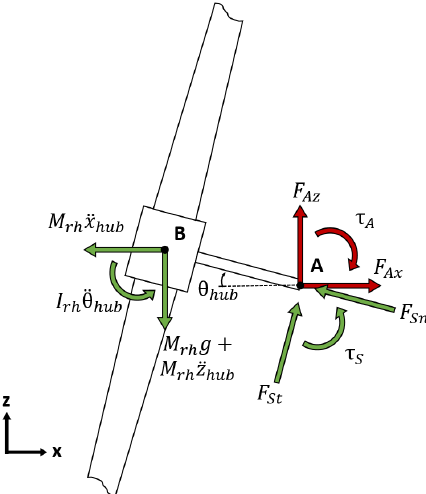
Figure 12. Free body diagram of the